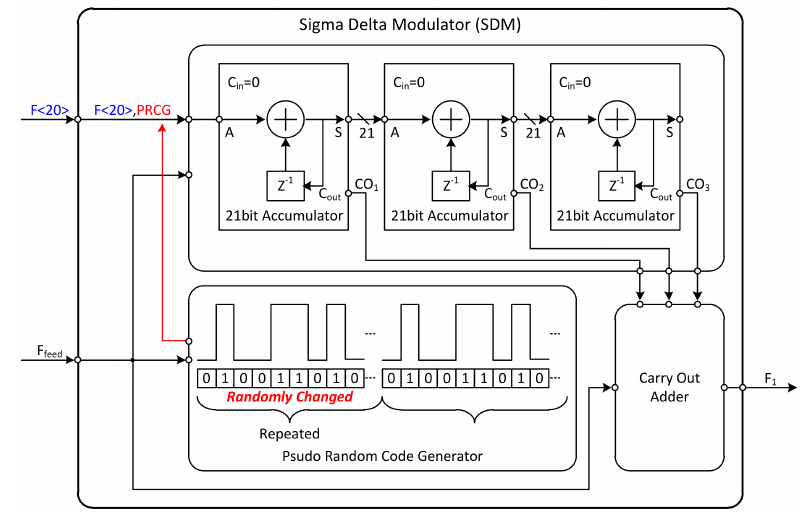
Figure 17. The detailed schematic of the